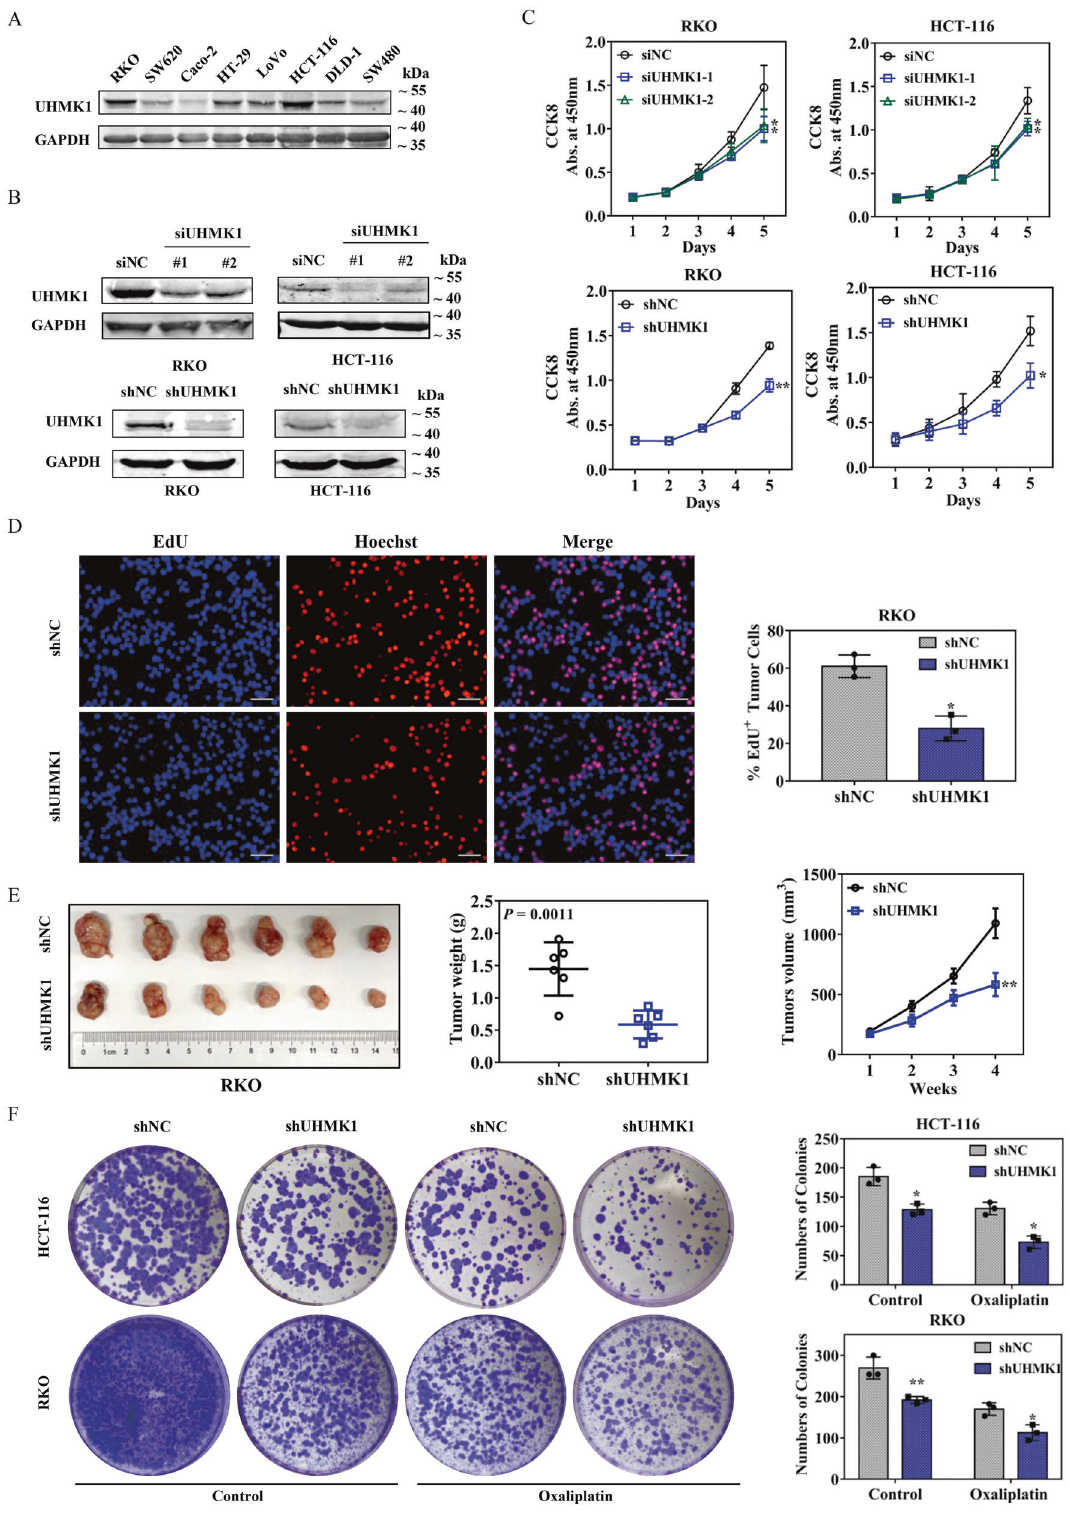
Fig. 2 UHMK1 downregulation suppressed CRC cell proliferation, tumorigenecity and oxaliplatin resistance. A UHMK1 expression levels in different human CRC cell lines were determined by western blotting. B Western blot results of UHMK1 knockdown in RKO and HCT-116 cells. C CCK-8 analysis of UHMK1 knockdown in RKO and HCT-116 cells. D EdU staining was used to observe cell proliferation after UHMK1 knockdown in RKO cells. The number of positive EdU cells was recorded. Scale bar: 100 μ m. E The image of tumors removed from nude mice implanted with RKO/shUHMK1 cells ( n = 6) or normal control RKO cells ( n = 6) for 4 weeks. Tumor weight and tumor volume were analyzed compared to the normal group. F Colony formation assay of UHMK1 knockdown in HCT-116 and RKO cells with or without oxaliplatin treatment (50 μ M). * p < 0.05, ** P < 0.01.